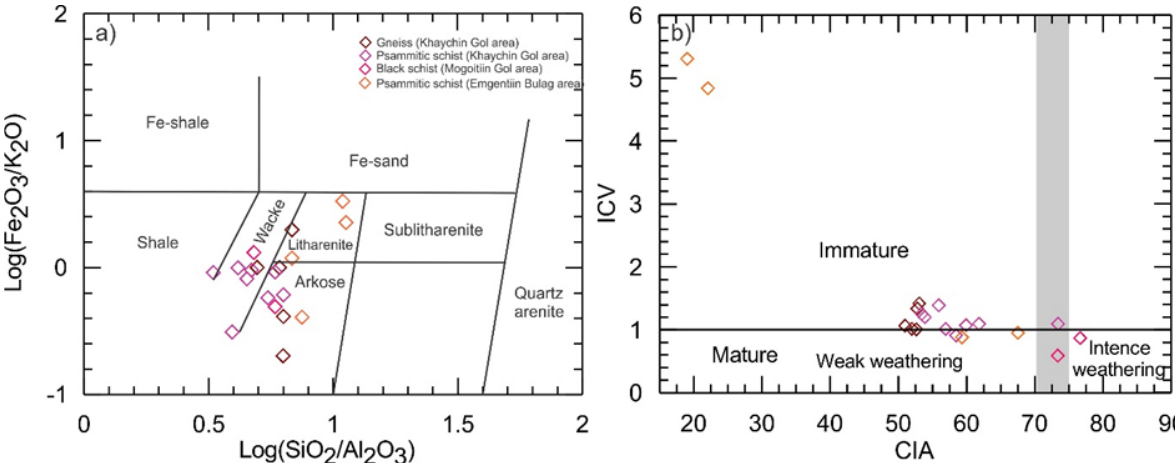
Fig. 10. Classification diagrams of black schist, gneiss and psammitic schist from the Mogoittin Gol, Khaychin Gol and Emgentiin Bulag areas. a) Log (SiO 1988); b) CIA–ICV diagram (after Nesbitt and Young, 1984).